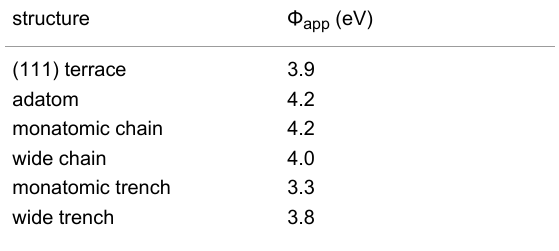
Table 1: Apparent barrier heights Φ app extracted from Figure